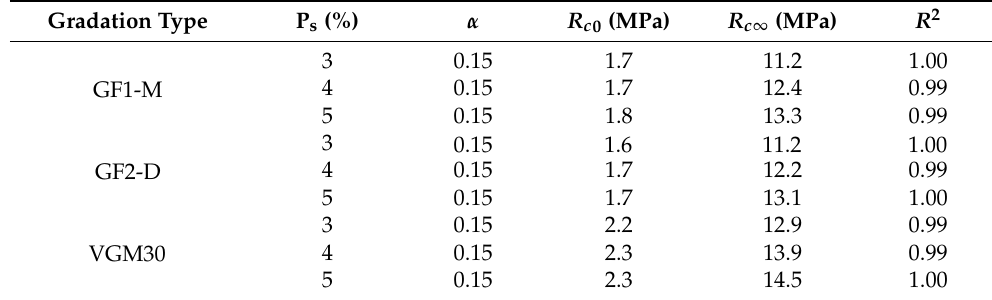
Table 6. Unconfined compressive strength growth equation parameters.